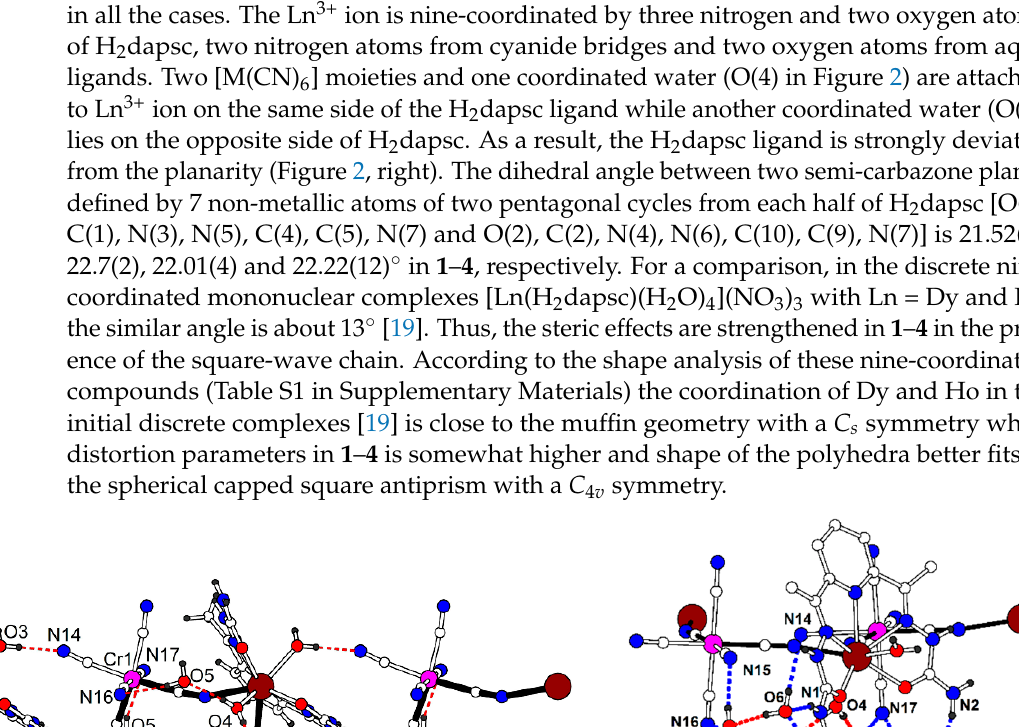
Figure 2. Asymmetric unit in 3 with atom numbering scheme, ( a ) top and ( b ) side view, ORTEP drawing with 50% probability ellipsoids). Symmetry codes: * (1 − x , 0.5 + y , 0.5 − z ), ** (1 − x , y − 0.5, 0.5 − z ).